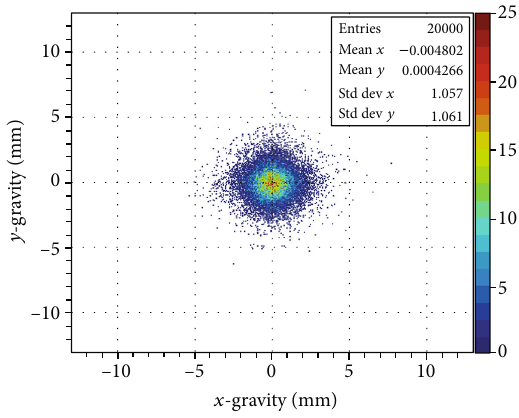
Figure 1: Relation between x LYSO matrix for 1 GeV electrons.